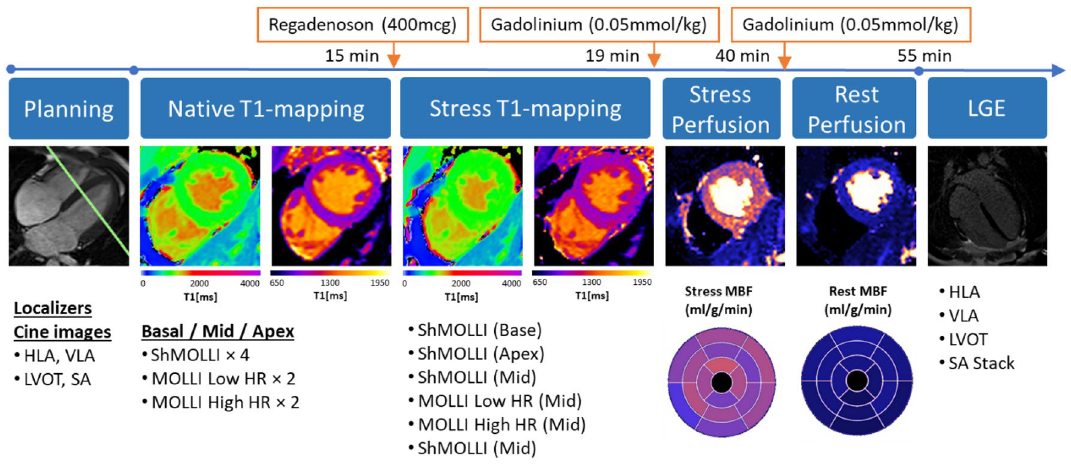
Figure 2. Modified second CMR scanning protocol for assessing stress T1 and MBF. Native T1-mapping is performed at rest using ShMOLLI, MOLLI Low HR, and MOLLI High HR in basal, mid-ventricular, and apical slice positions. Stress T1-mapping is performed following administration of regadenoson (IV 400 mcg) in the basal, apical, and mid-ventricular slices as illustrated. Stress is reversed with aminophylline (IV 100 mg) at ~ 25 min. Rest perfusion and late gadolinium enhancement images are